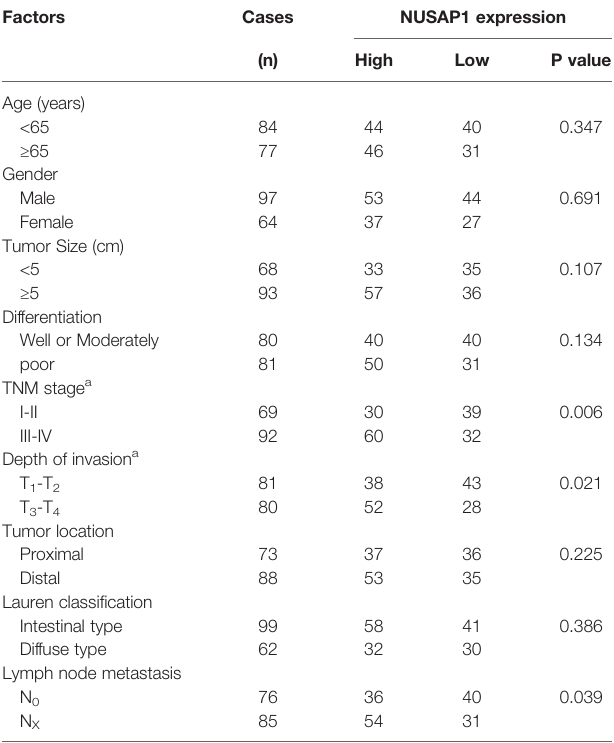
TABLE 1 | The correlation between the expression of NUSAP1 and clinicopathological parameters of patients with GC.